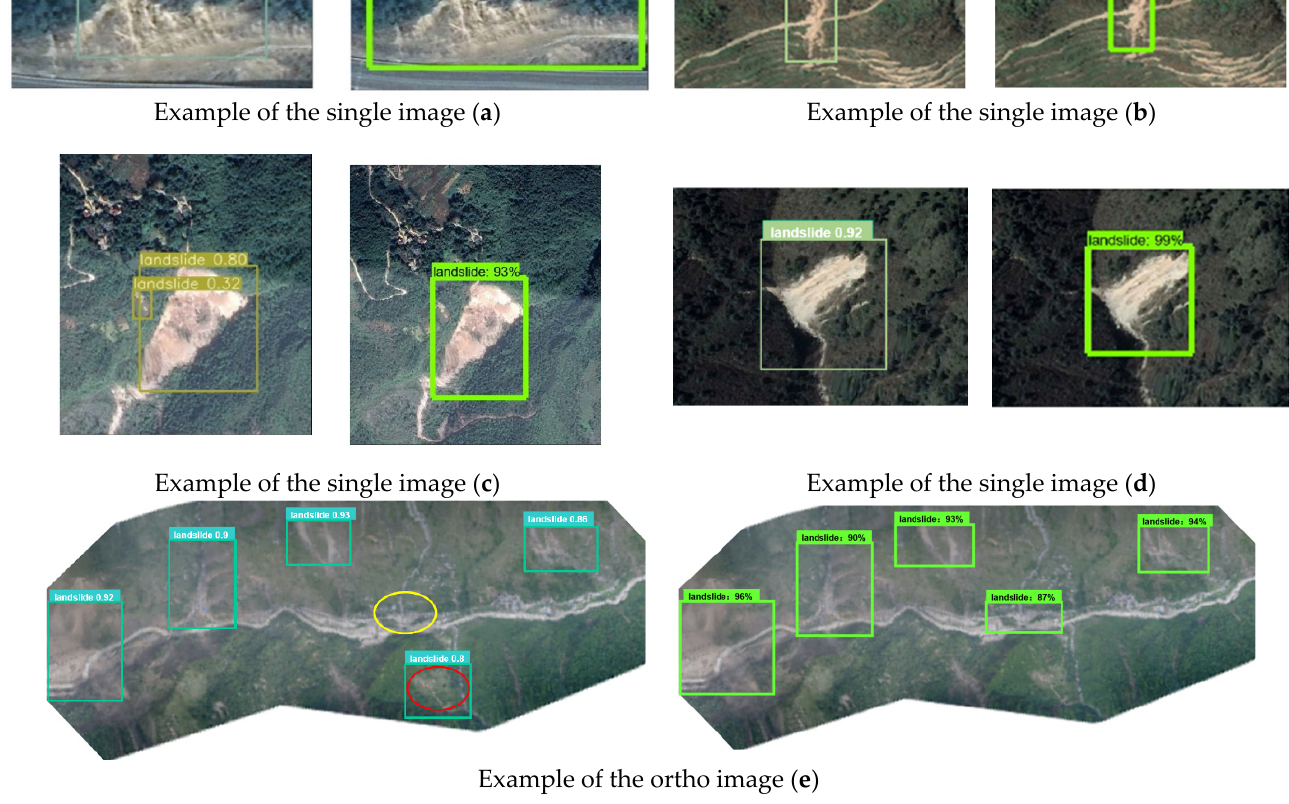
Figure 10. The examples of test results of the SSD ( left ) and the transfer learning model ( right ).